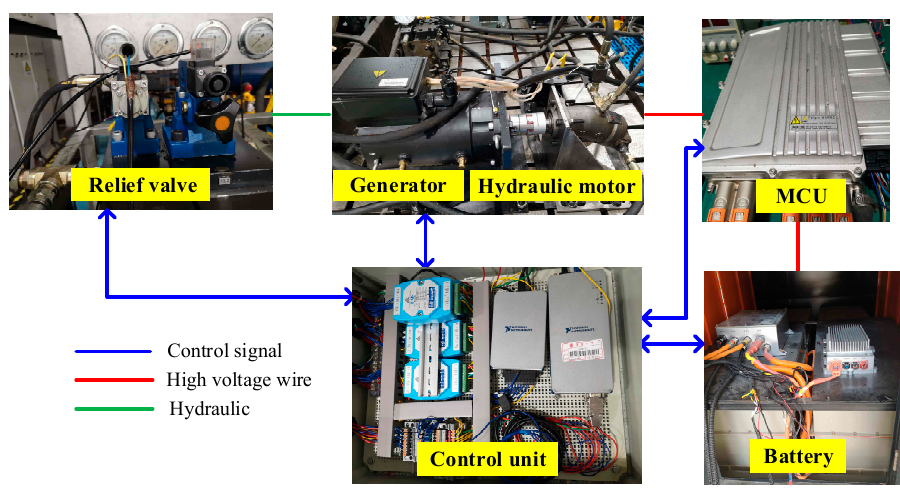
Figure 21. Overflow loss energy regeneration test platform.